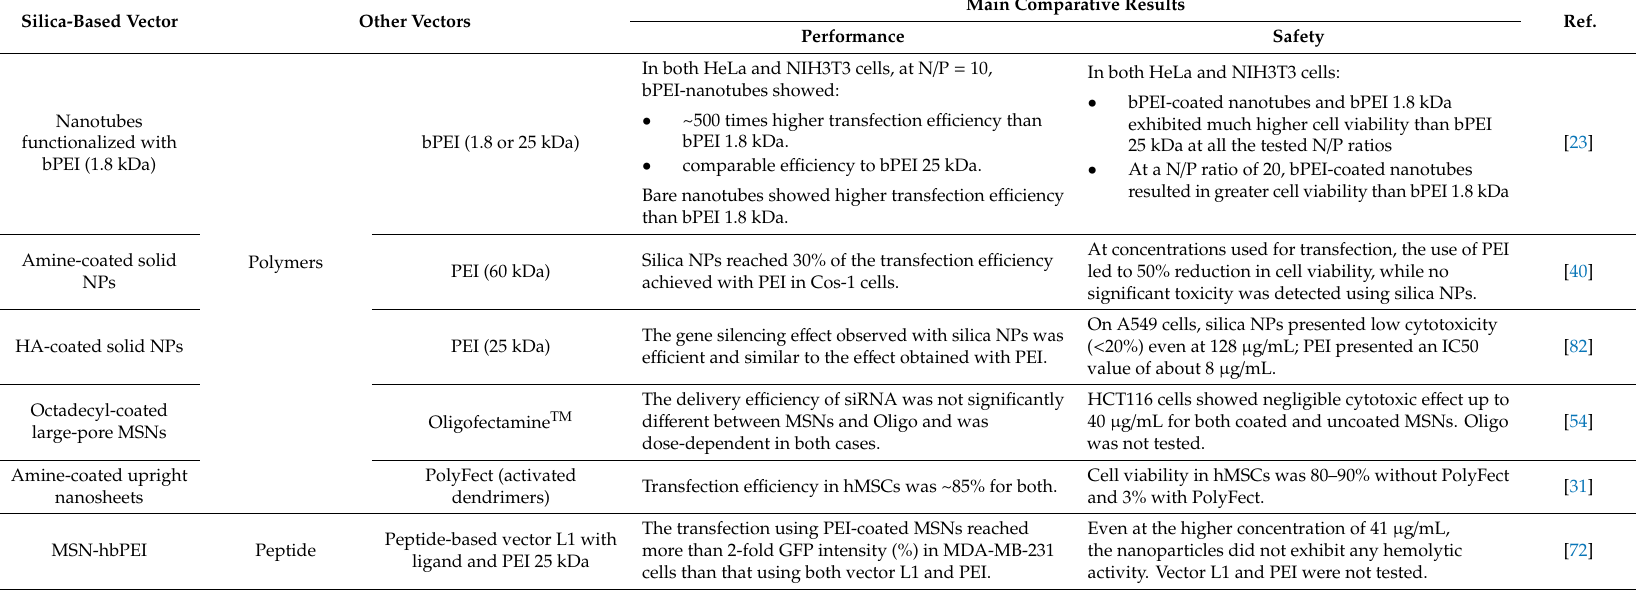
Table 4. Comparative studies between silica-based systems and other